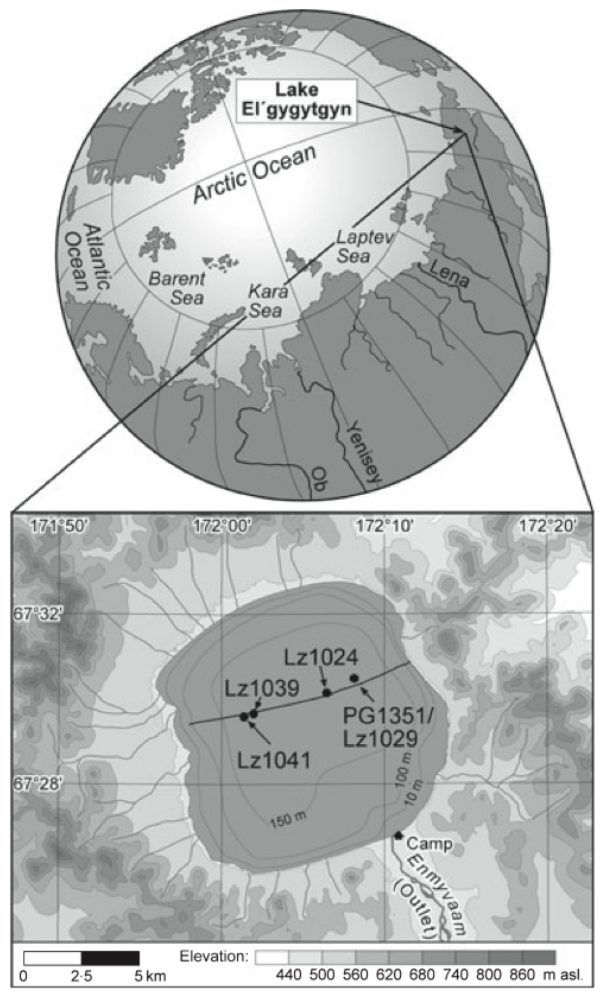
Fig. 1. Lake El’gygytgyn site location (67 ◦ 30 0 N, 172 ◦ 05 0 E) and the location of core LZ1029 in relationship to other nearby sediment cores referred to in the